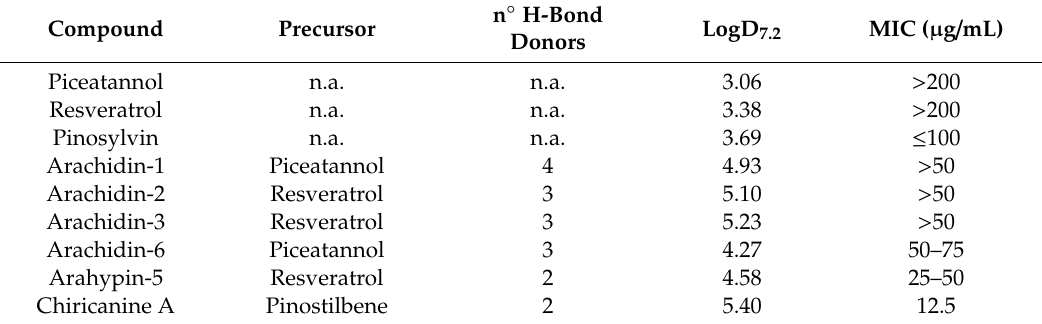
Figure 5. Structures of prenylated stilbenoids from de Bruijn et al. (2018) [68] and Wu et al. (2020) [69]. Table 7. Structural characteristics and antibacterial activity of the prenylated compounds from de Bruijn et al. (2018) [68].